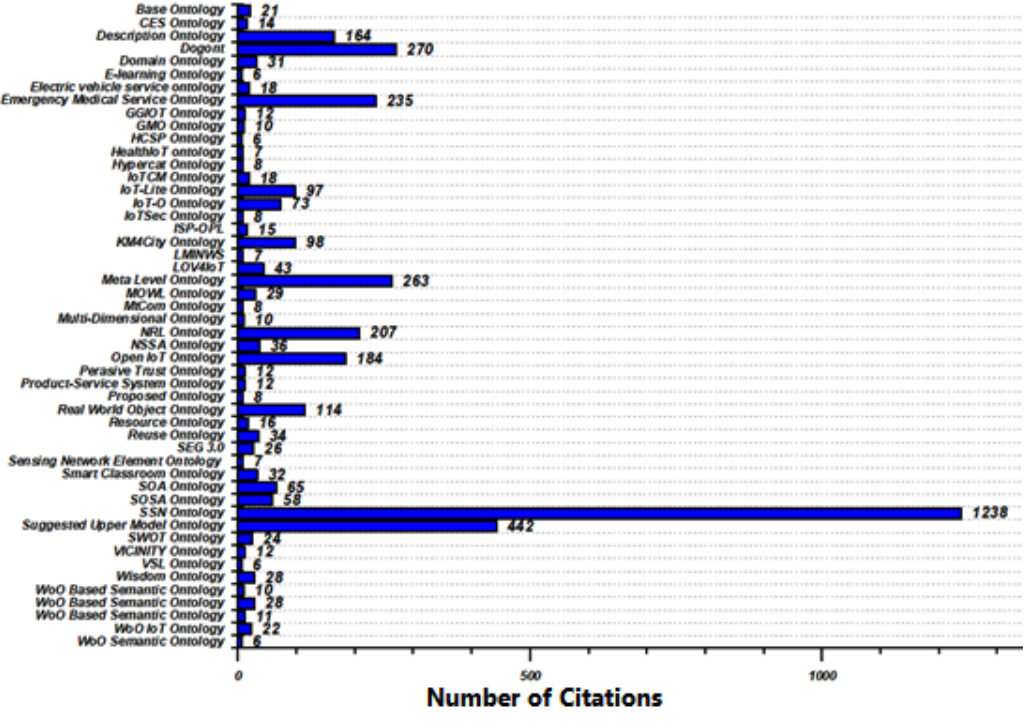
Figure 5. Existing ontologies in IoT.